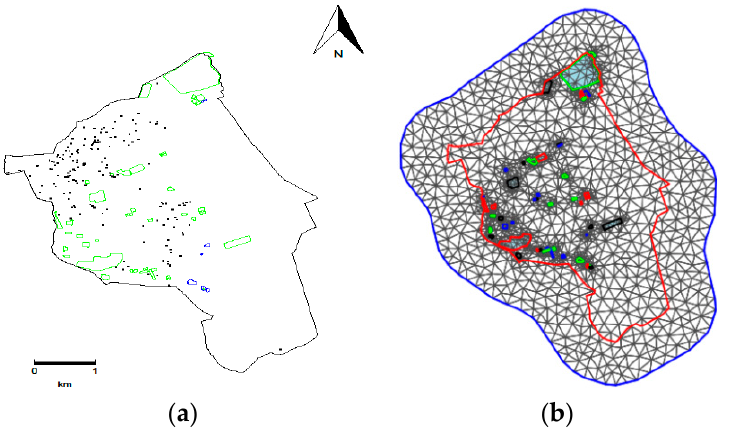
Figure 8. Area of interest and its corresponding mesh: ( a ) Area of interest and two types of obstacle areas; ( b ) Triangular grid. Note: ( a ) The area enclosed by the green line indicates the meadow, the area enclosed by the blue line illustrates the water system area and the black dots indicate the location of burglaries.